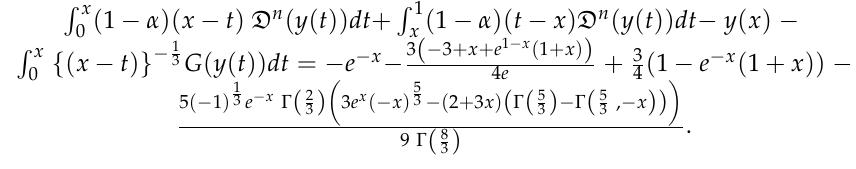
Table 4. MAEs of Examples 5 and 3 for different values of 𝑅.